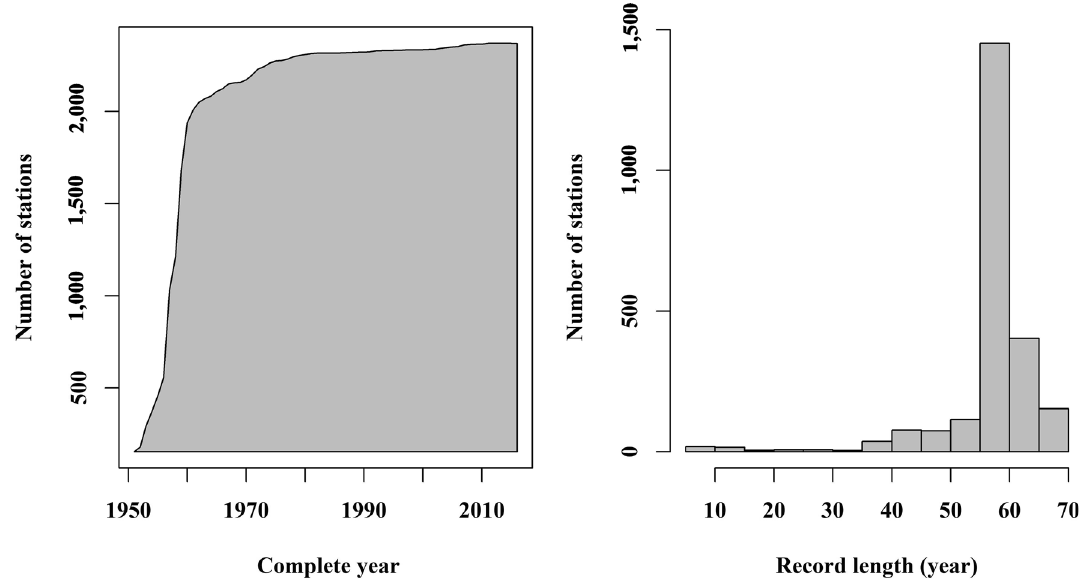
Fig. 1 Precipitation observations in terms of a the number of weather stations with complete records for a given year; and b the number of stations with different record lengths of daily precipitation